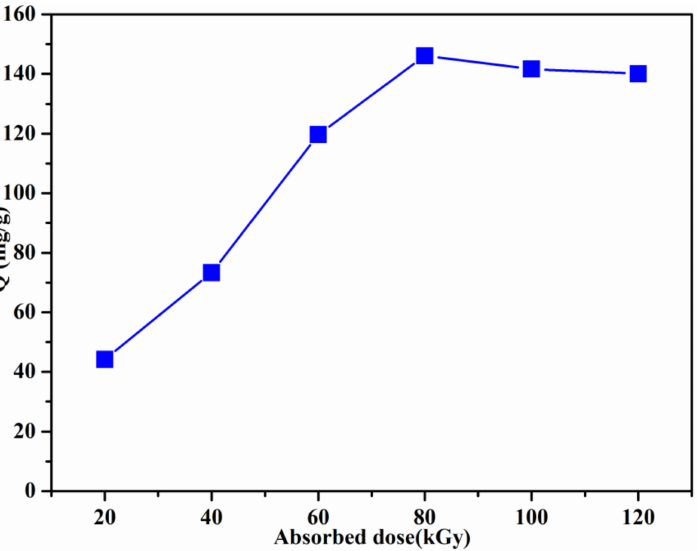
Figure 6. Adsorption capacity of Ce(III) under different absorbed doses (Dose rate = 20 kGy/pass, GMA concentration = 40